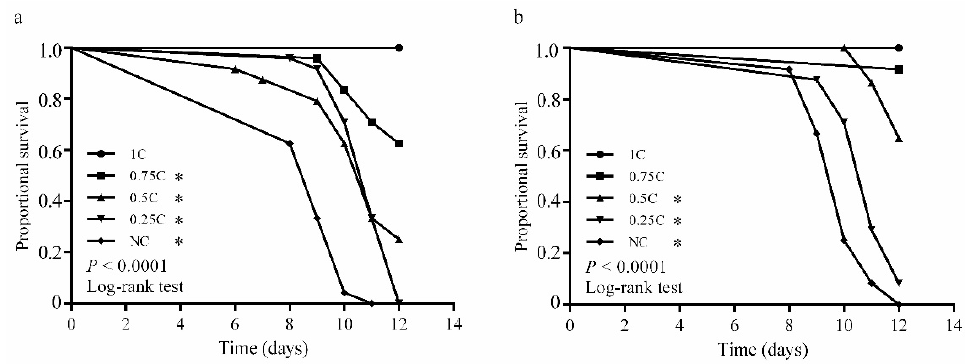
Figure 2. Larval survival of Mythimna separata ( a ) and Spodoptera frugiperda ( b ) on five cholesterol concentrations by the 12th day. * represents a significant difference in comparison to 1C at p < 0.05.